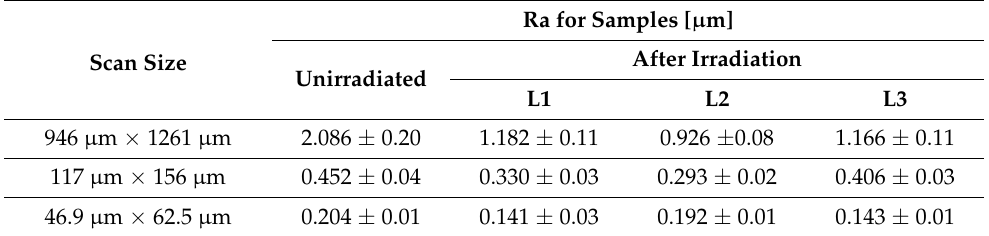
Figure 5. The surface microgeometry maps made of porcelain: ( A1 ) untreated control sample; ( A2 ) after irradiation with L1; ( A3 ) after irradiation with L2; ( A4 ) after irradiation with L3 and their height profiles made in the x-axis (upper profile) and y-axis (lower profile). Table 5. The roughness parameters for the porcelain samples before and after irradiation.